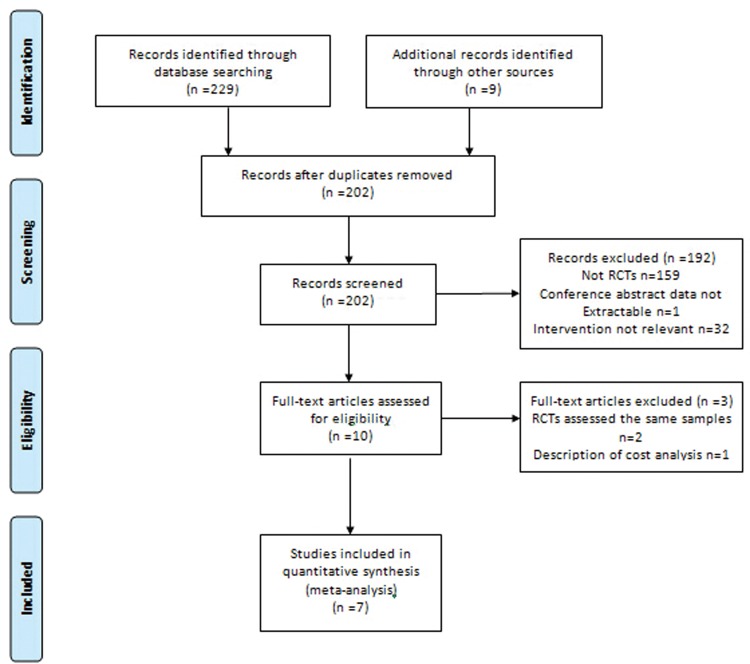
Flowchart.Flowchart of the selection of randomized controlled trials (RCTs) for the meta-analysis.